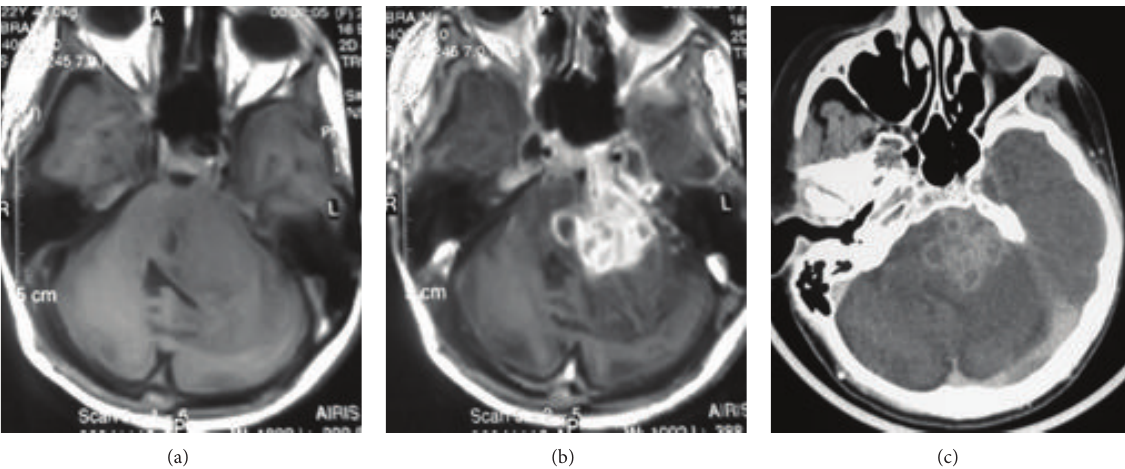
Figure 3: Tuberculous abscess mimicking a cerebellopontine angle tumor in a 22-year-old female with miliary pulmonary tuberculosis, right hemiparesis, left facial paresis, and sixth and seventh cranial nerves involvement. Axial T1-weighted image (a) shows a predominantly isosignal lesion in the left hemisphere of cerebellum with extension to CPA and prepontine cistern accompanied by marked peripheral edema and mass effect. Multilobulated enhancement of the lesion is seen in the postcontrast T1-weighted (b) and CT (c)